Question: Identify the chart type used in this figure.
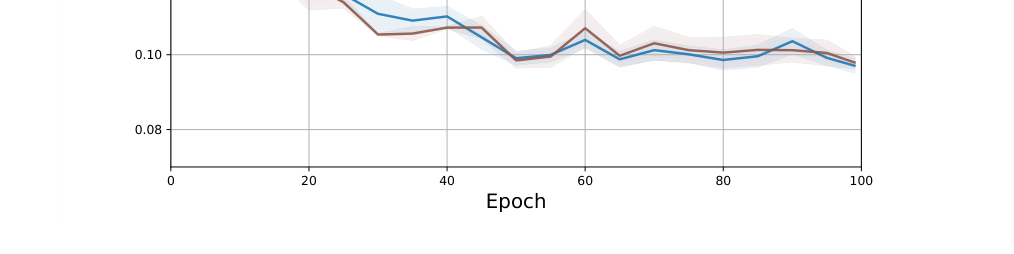
Answer: bar